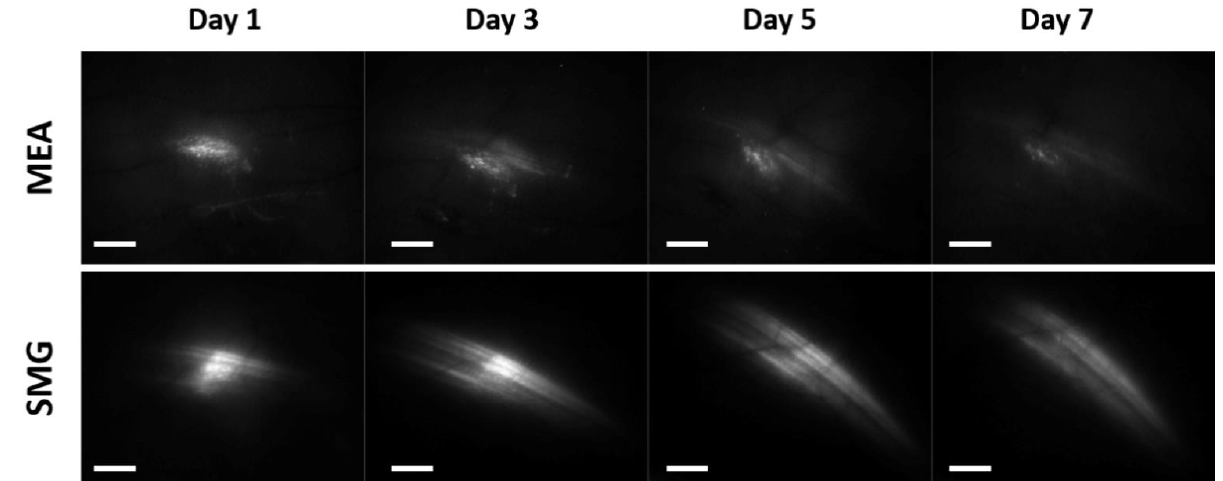
Figure 6. Fluorescence of EGFP protein following GET of the reporter plasmid pEGFP-N1 coding for EGFP in mouse skin. Representative images of EGFP expression in the skin of mice after GET using the multi-electrode array (MEA) electrodes and the previously published pulse delivery protocol: 12 pulses, amplitude 60 V, duration 150 ms, and pulse repetition rate 2.82 Hz (upper part of the figure); and the newly developed pulse generator in combination with the new applicator and pulse delivery protocol for GET to skin cells — SmartGene (SMG): 18 sequences with 4 pulses, burst repetition rate 50 Hz, amplitude 560 V, duration of each pulse 100 µs, and pulse repletion rate 5 kHz (lower part of the figure). Scale bar: 2 mm.